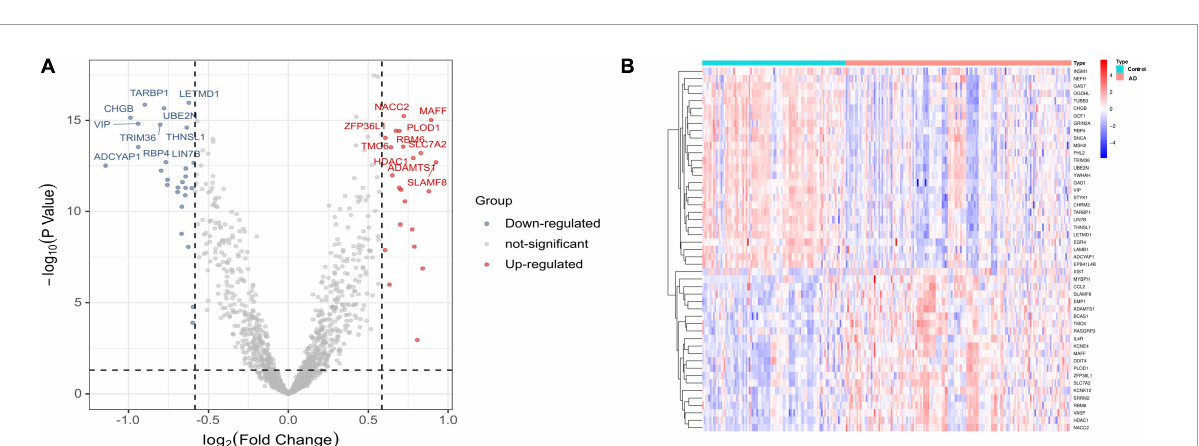
FIGURE1 The flowchart of the analysis process.